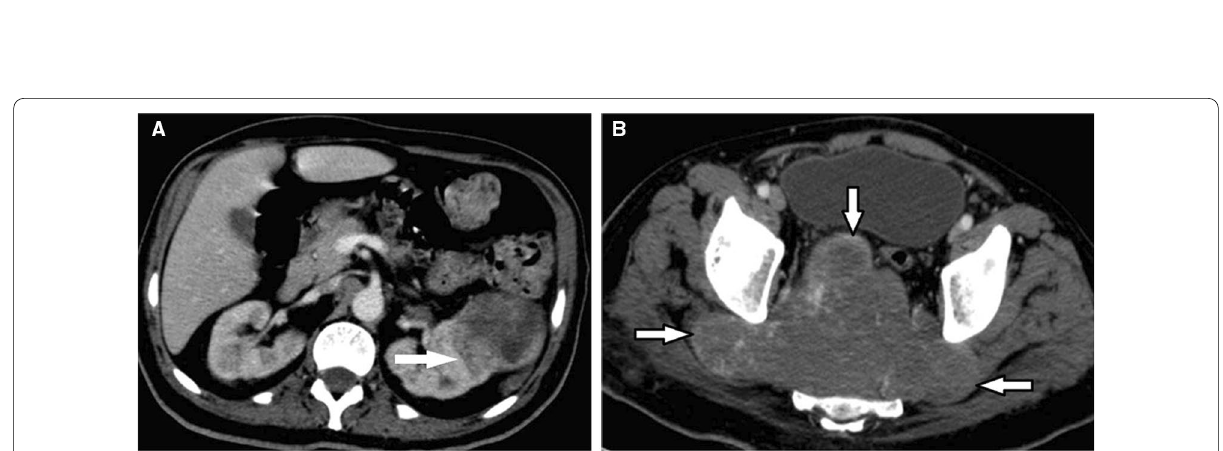
Fig. 3 36‑year‑old male presented with bilateral sciatica. a MDCT scan revealed left renal mass (arrow) (pathologically proved renal cell carcinoma) and b locally advanced presacral mass invading sacrum (arrows) (pathologically proved malignant